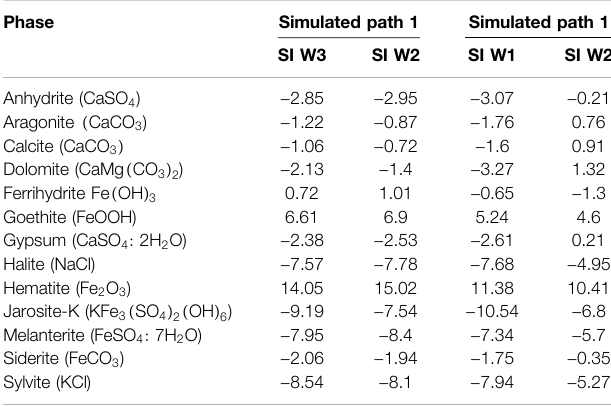
TABLE 4 | Saturation index (SI) of some samples in Boca Itata.